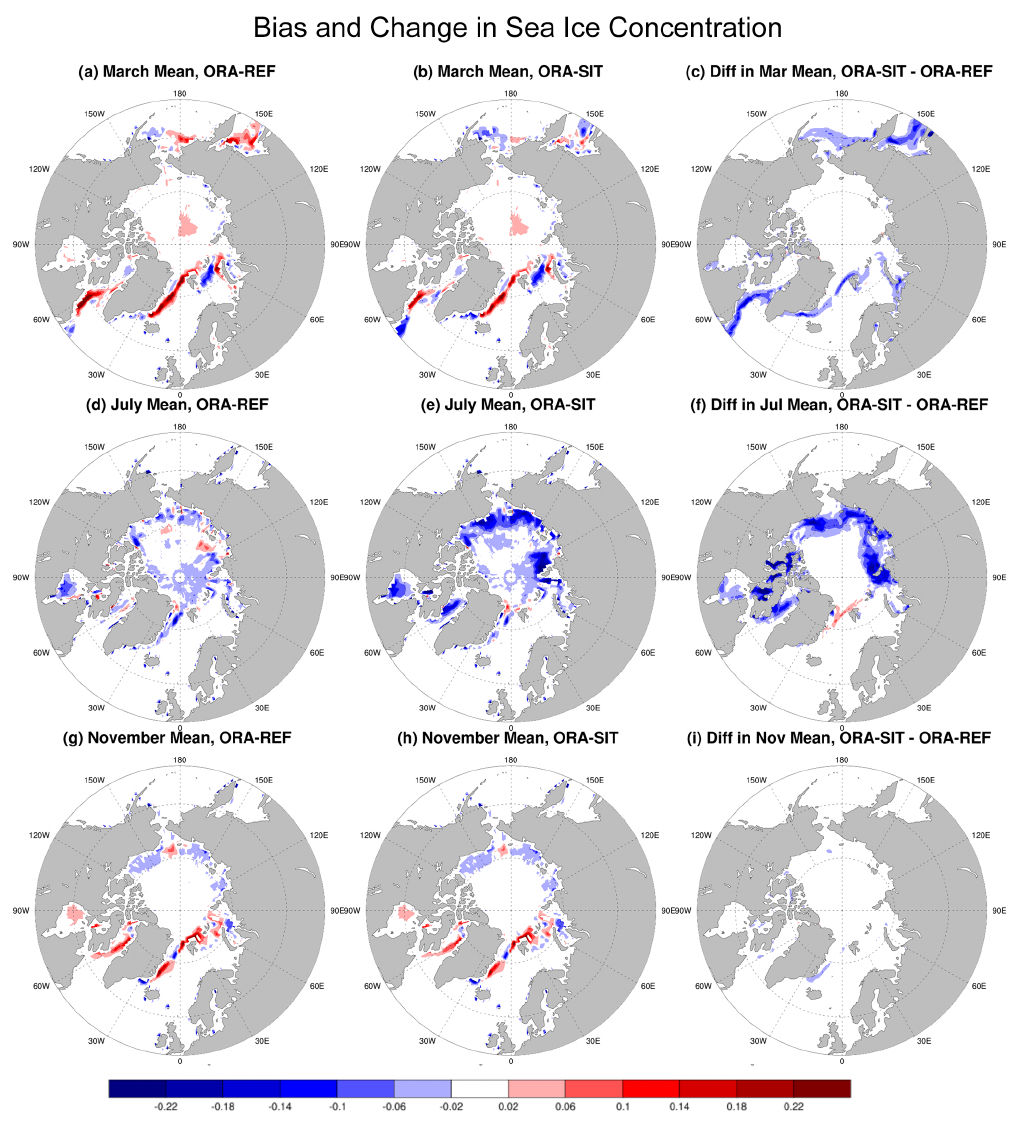
Figure 3. Bias in monthly-mean (2011–2016) sea ice concentration with respect to OSI-401-b observations for ORA-REF (a, d, g) , ORA- SIT (b, e, h) , and the difference between ORA-SIT and ORA-REF for panels (c) , (f) and (i) . Panels (a) , (b) and (c) are for March; panels (d) , (e) and (f) are for July; and panels (g) , (h) and (i) are for